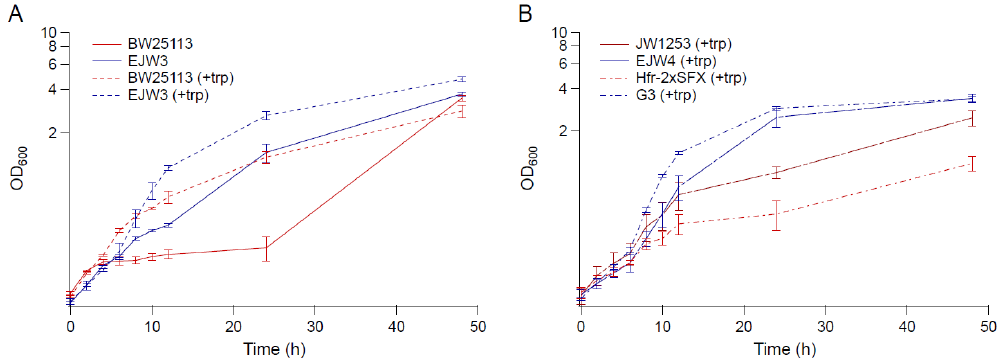
Figure 1. Growth kinetics in M9 supplemented with 0.6 M NaCl. ( A ) BW25113 and EJW3 in M9 supplemented with 0.6 M NaCl (solid lines: without tryptophan, and dashed lines: with 50 µg mL −1 tryptophan supplementation). ( B ) Tryptophan auxotrophic strains JW1253, EJW4, HFr-2×SFX- and G3 in M9 supplemented with 0.6 M NaCl and 50 µg mL −1 tryptophan. Red lines: strains without rpoC mutation. Blue lines: strains with rpoC mutation. Error bars are standard deviations.